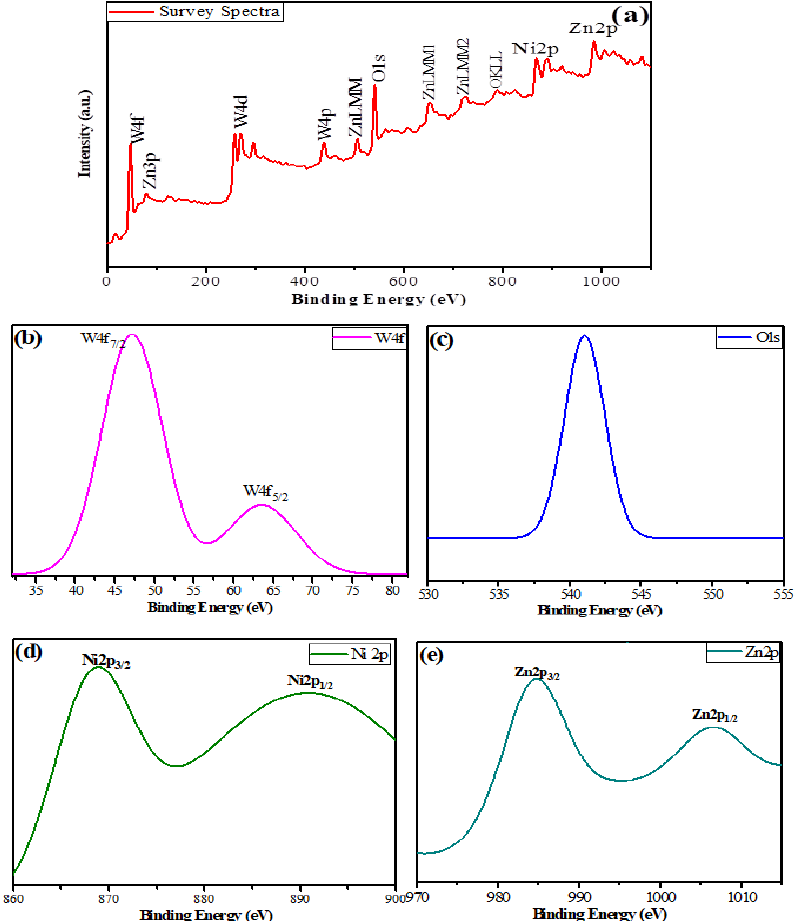
Figure 7. X-ray photoelectron spectroscopy (XPS) of ZnNiWO 4 NPs’ ( a ) survey spectra, ( b ) W4f spectra, ( c ) O1s spectra, ( d ) Ni2p spectra, and ( e ) Zn2p spectra.